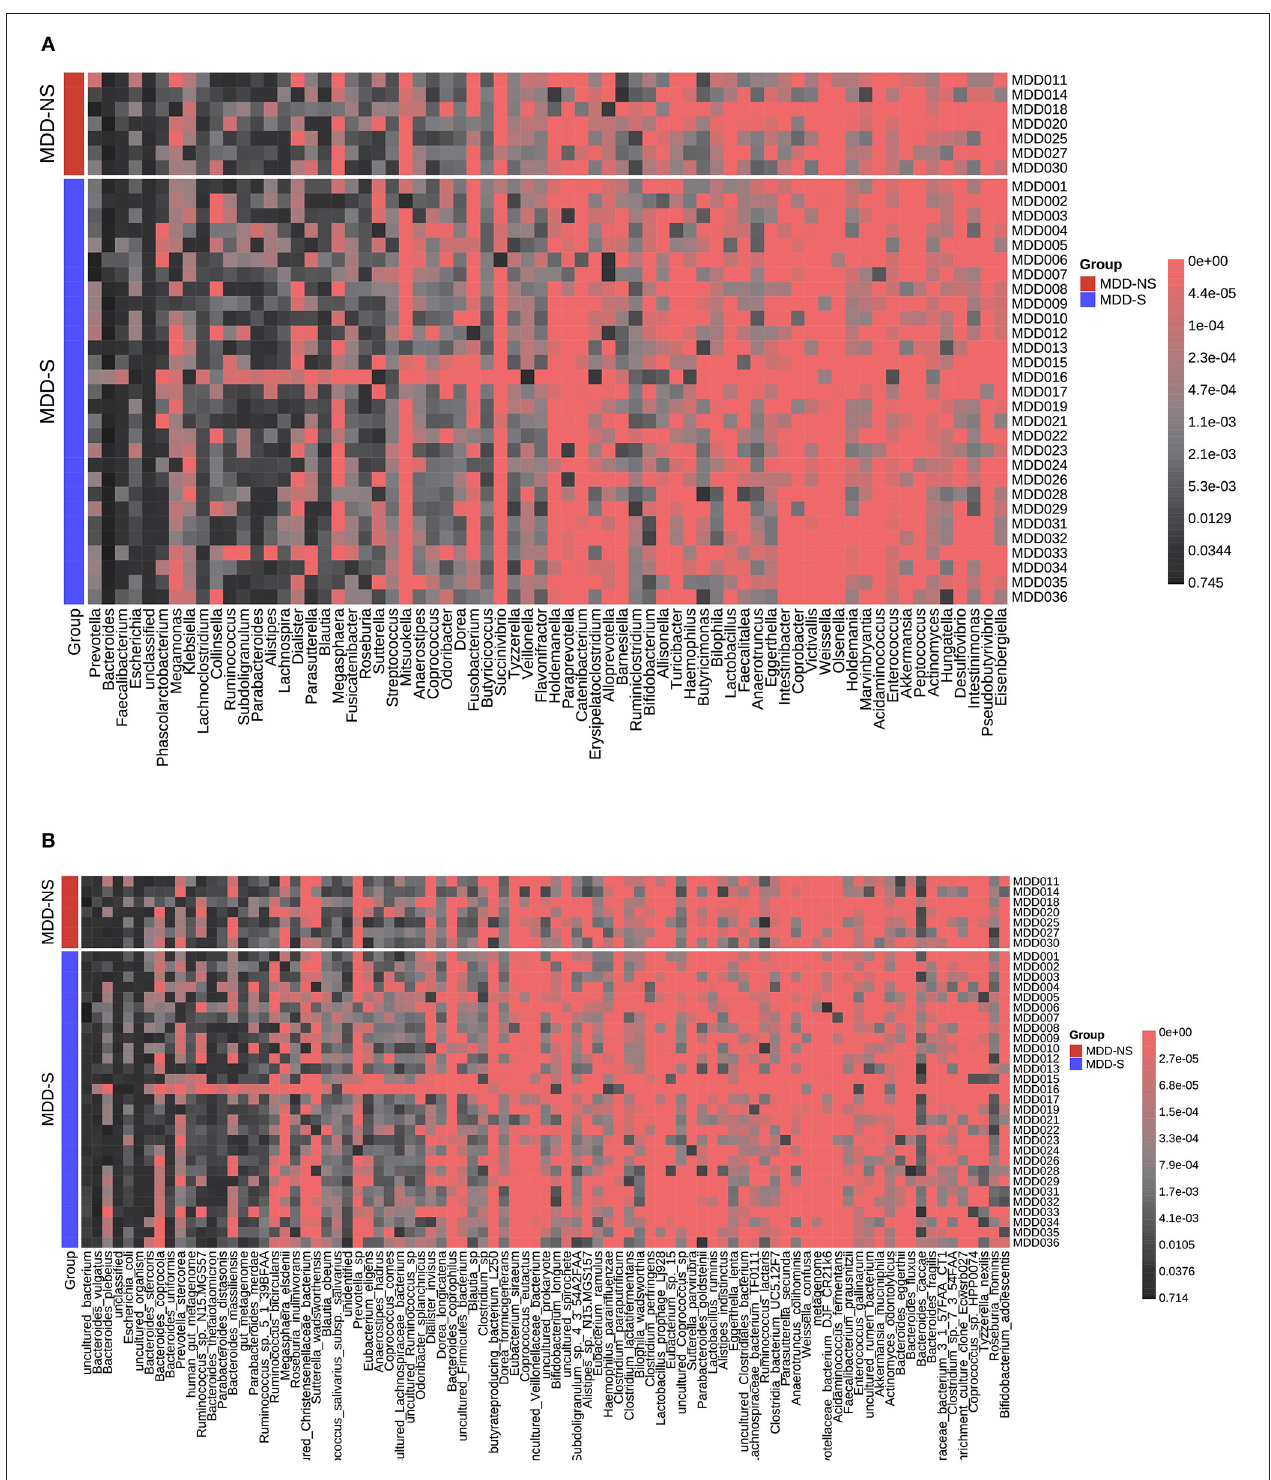
FIGURE 6 | Relative abundance distribution for MDD-S and MDD-NS at the genus level (A) and species level (B) . MDD-S stands for MDD patients with sleep disorder (PSQI > 5), and MDD-NS stands for MDD patients without sleep disorder (PSQI ≤ 5).